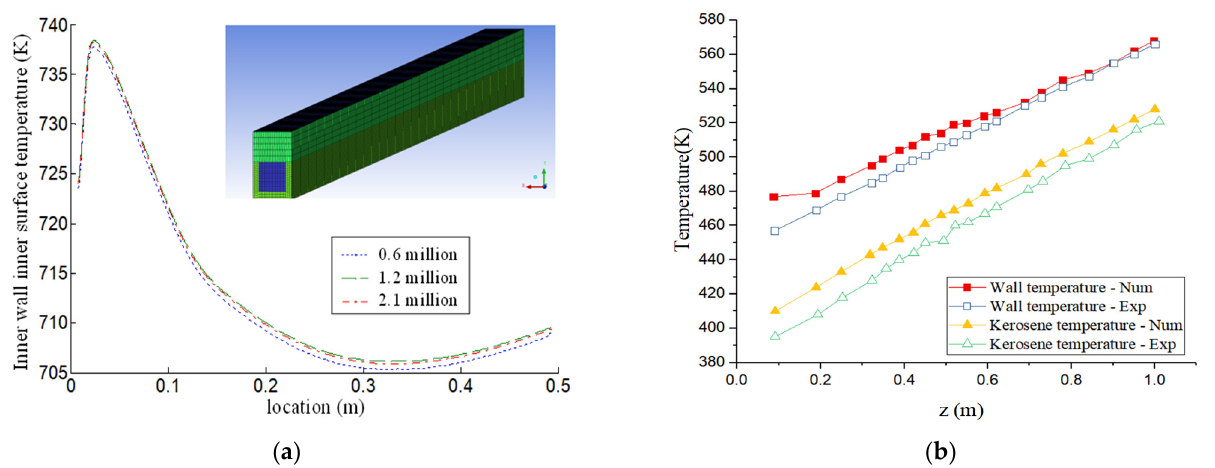
Figure 4. ( a ) Grid independence and ( b ) validation by kerosene flow in a heating